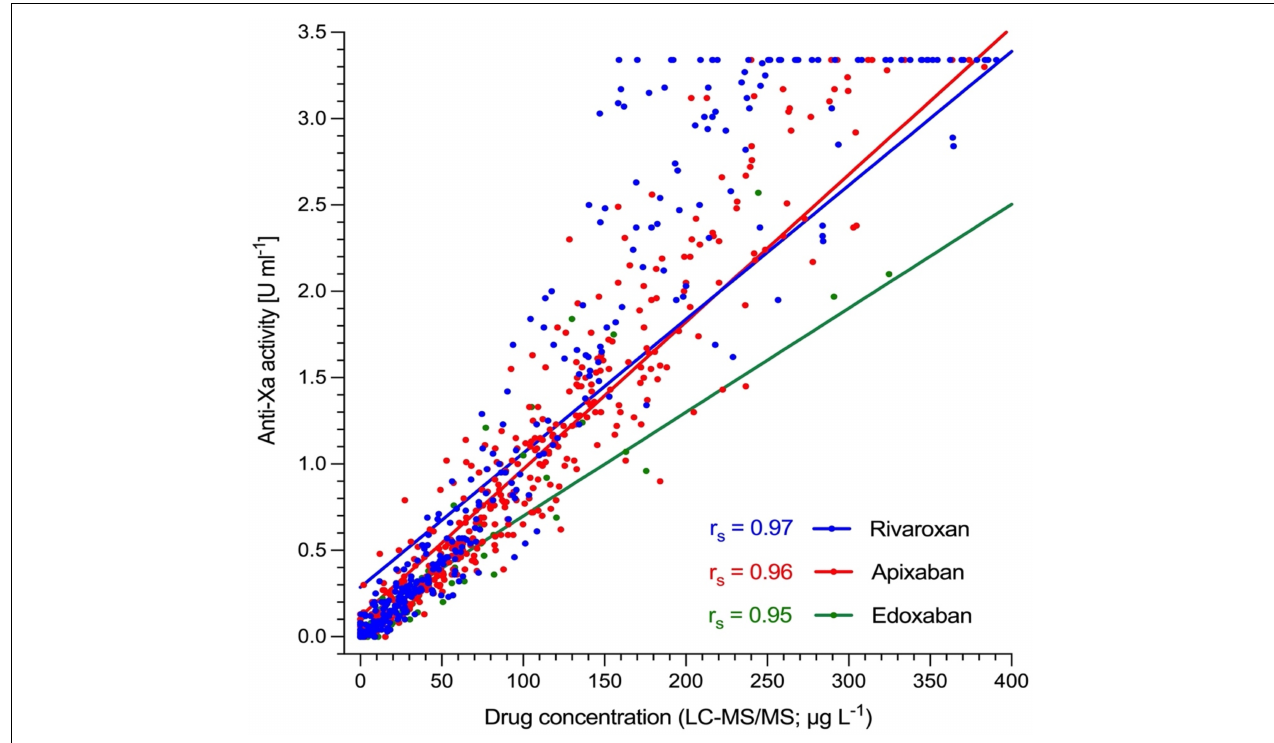
FIGURE 2 | Association of heparin-calibrated anti-Xa measurements with drug concentration in 845 patients taking rivaroxaban, apixaban, or edoxaban in clinical practice. Ultra-performance liquid chromatography-tandem mass spectrometry (LC-MS/MS) was used to determine drug levels. Spearman’s correlation coefficient (r s ) was 0.97 for rivaroxaban (95% CI 0.97–0.98), 0.96 for apixaban (0.95–0.97), and 0.96 for edoxaban (0.94–0.99). The overall r s was 0.97 (95% CI,